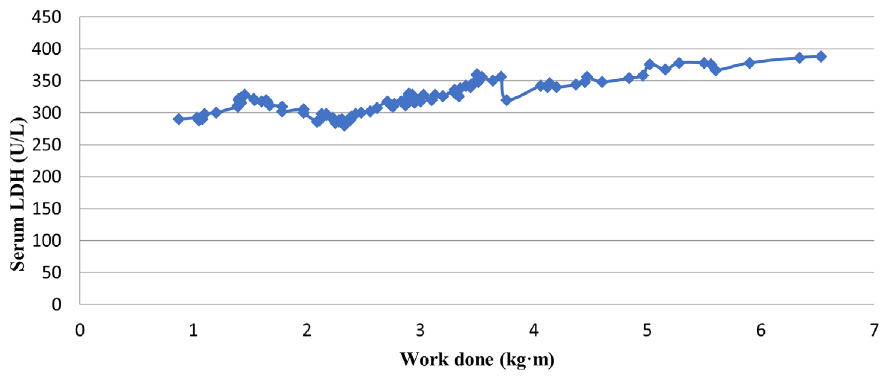
Figure 2. A scatter plot representation of the overall correlation of work done and serum LDH levels in prediabetic individuals